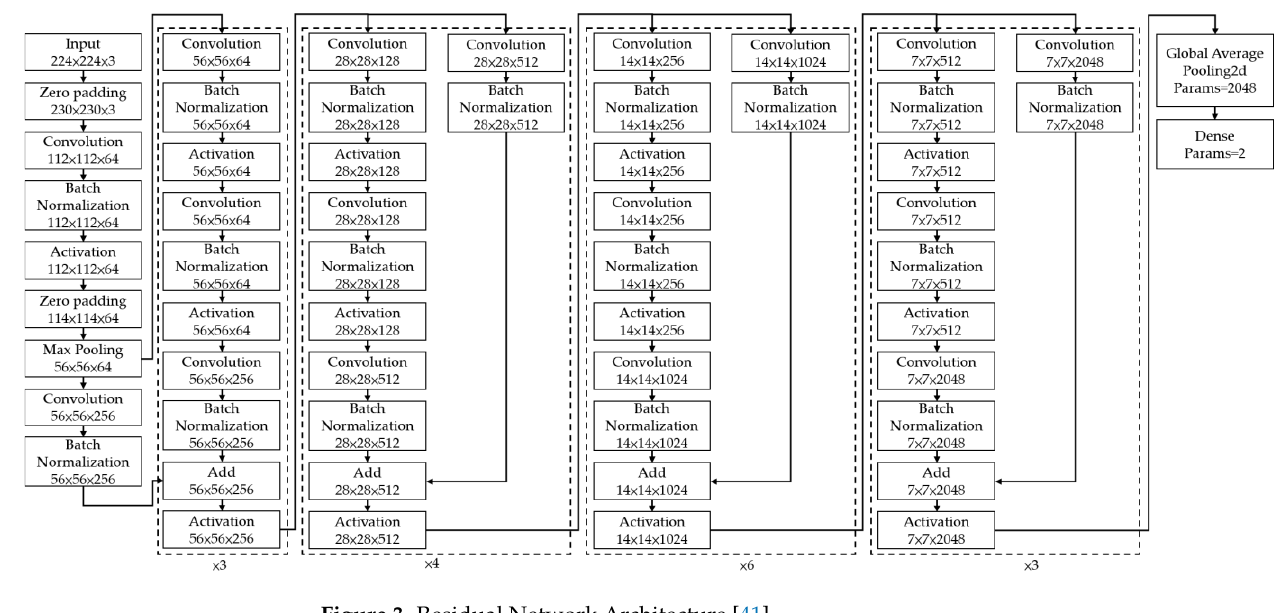
Figure 3. Residual Network Architecture [41].